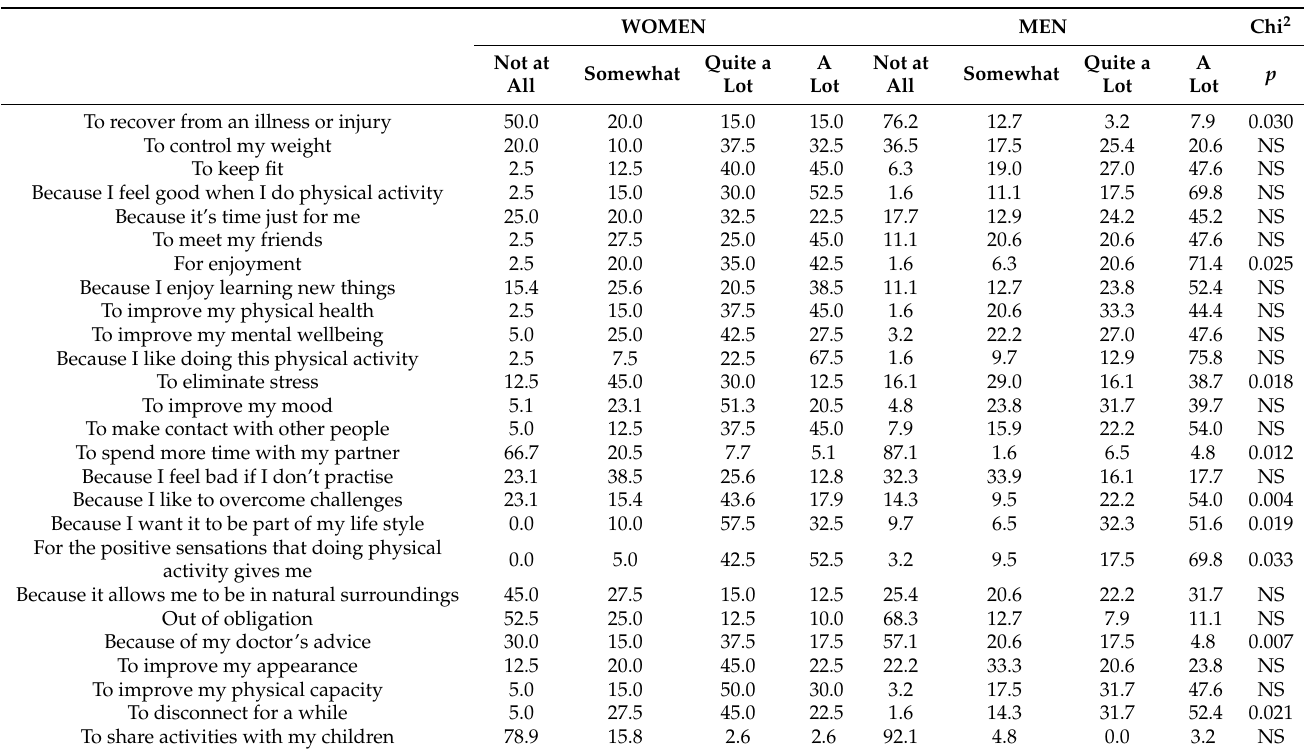
Table 4. Results (%) referring to the differences in the perceived motives for practising physical activity and sport according to